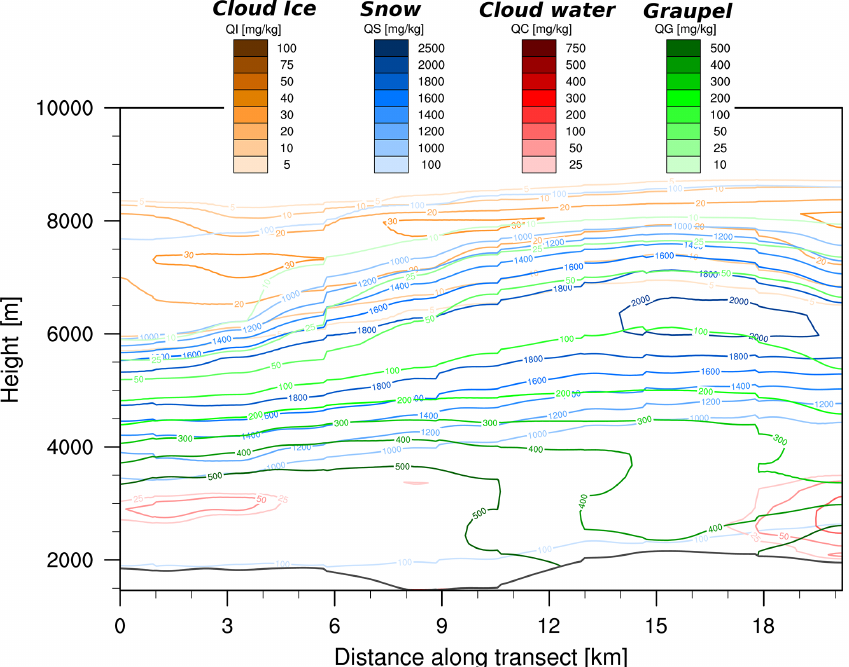
Figure 11. Mixing ratios of hydrometeor contents obtained with the COSMO2 numerical weather model along the RHI transect of MXPol (same as Fig. 10) at 15:15UTC on the 26 March 2010 in Davos (CH). Mixing ratios are given for cloud ice (QI), snow (QS), cloud water (QC), and graupel